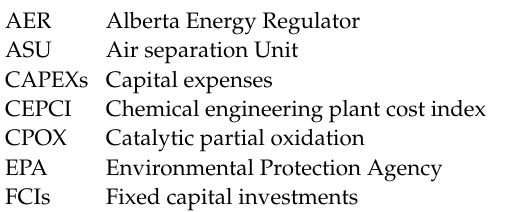
Table 6. We assumed E 0,HC6re = E 0,HC6 (lines 30–31 of kinetics.py), Figure S2: Distributions of the feedstock compressor duty (a), CPOX temperature (b), H 2 /CO ratio in syngas (c), CO conversion in the FT reactor (d), and asf chain growth probability factor (e) for the three scenarios, Code— Python.rar: Source code of the Python